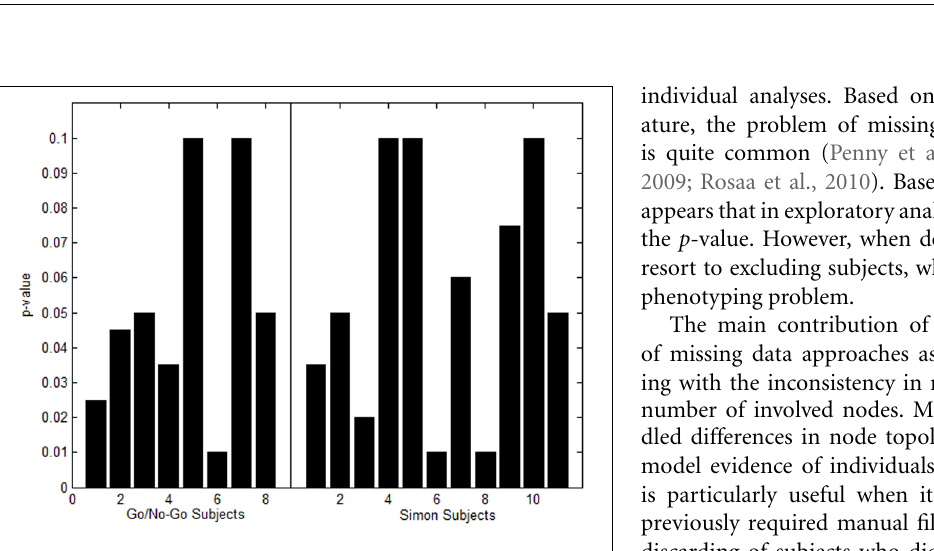
FIGURE 7 | Histogram of highest p -values to produce missing nodes in Go/No-Go Task (left) and Simon task